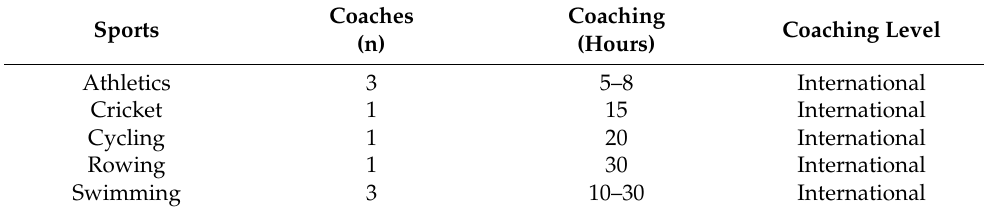
Table 2. Coach participant